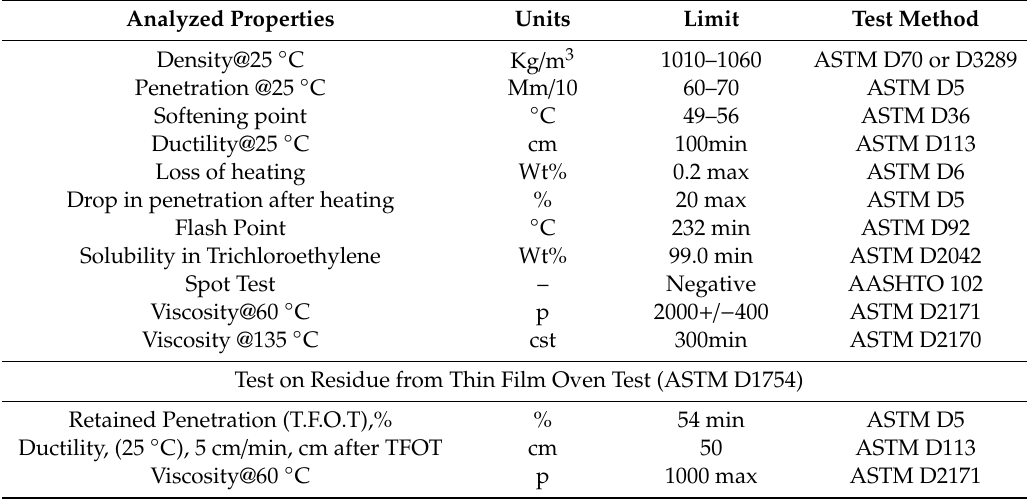
Table 1. Standards for testing bitumen properties.